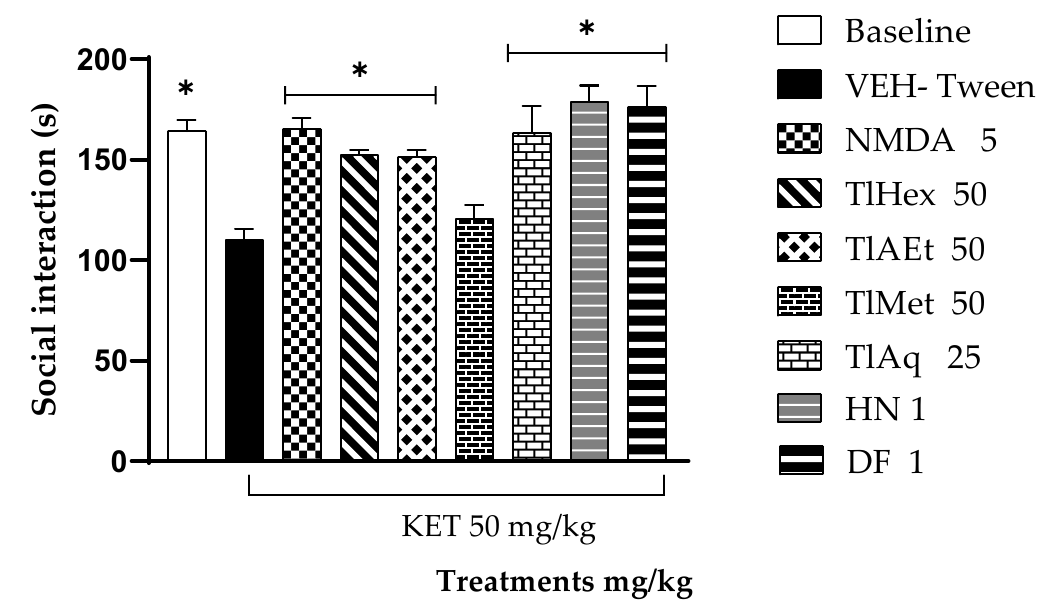
Figure 6. Effect of T. lucida extracts, herniarin (HN), and dimethylfraxetin (DF) on acute schizophrenia-like symptoms induced with KET 50 mg/kg in the Social Interaction Test (SIT) in mice. Data show mean ± S.E.M. of 5 animals * p < 0.05 indicates statistically significant differences using an ANOVA followed by Dunnett’s Test compared with the VEH-Tween group.